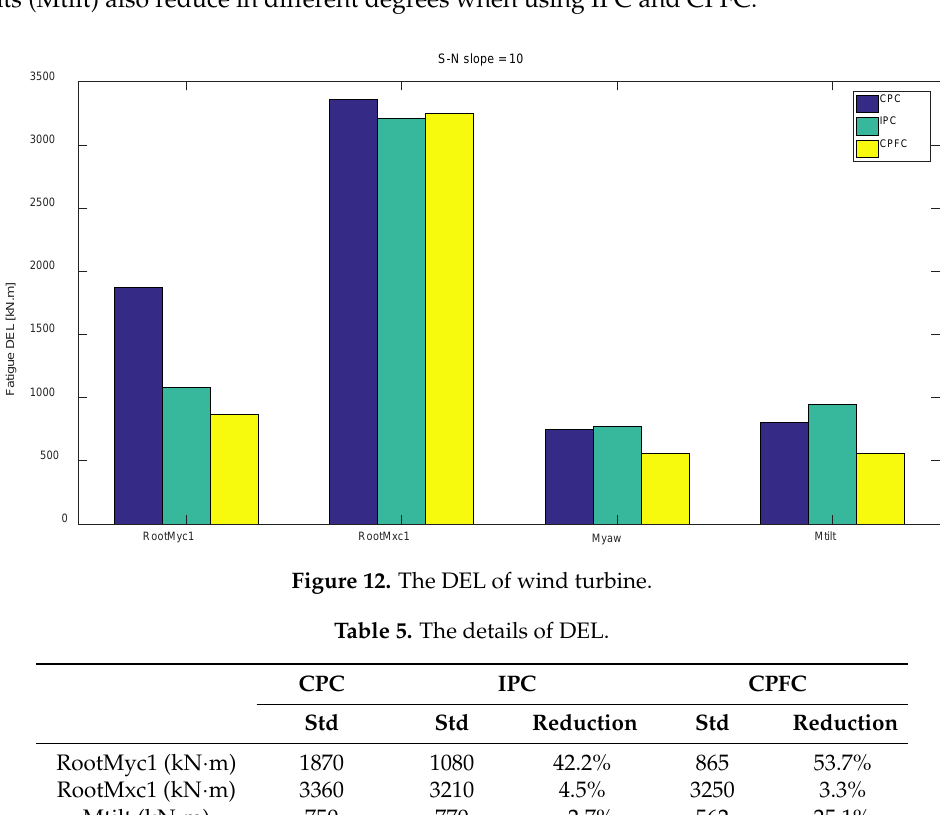
Figure 11. The blade 1 pitch angles and TEFs deflection angles. ( a ) The blade 1 pitch angles; ( b ) The TEFs deflection angles.